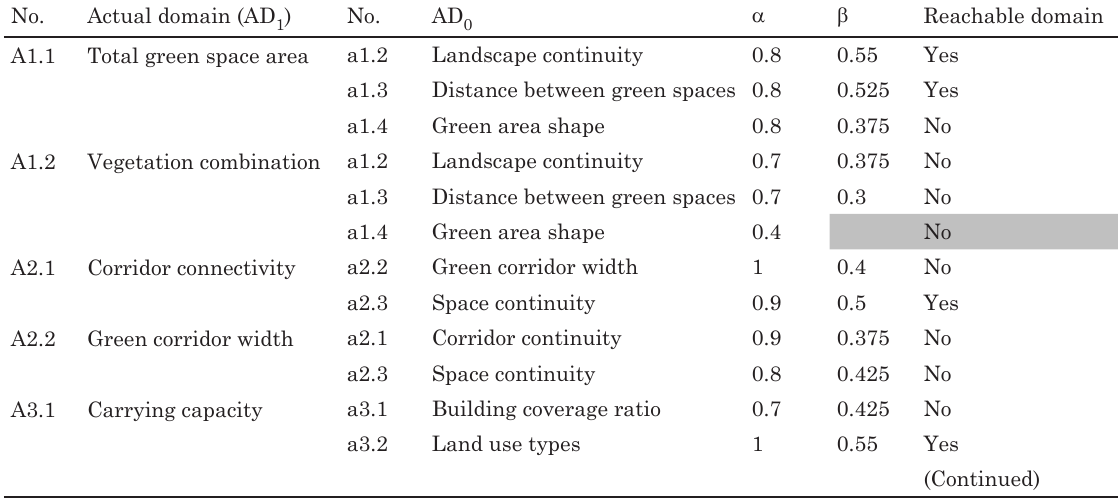
table 3. reachable domain